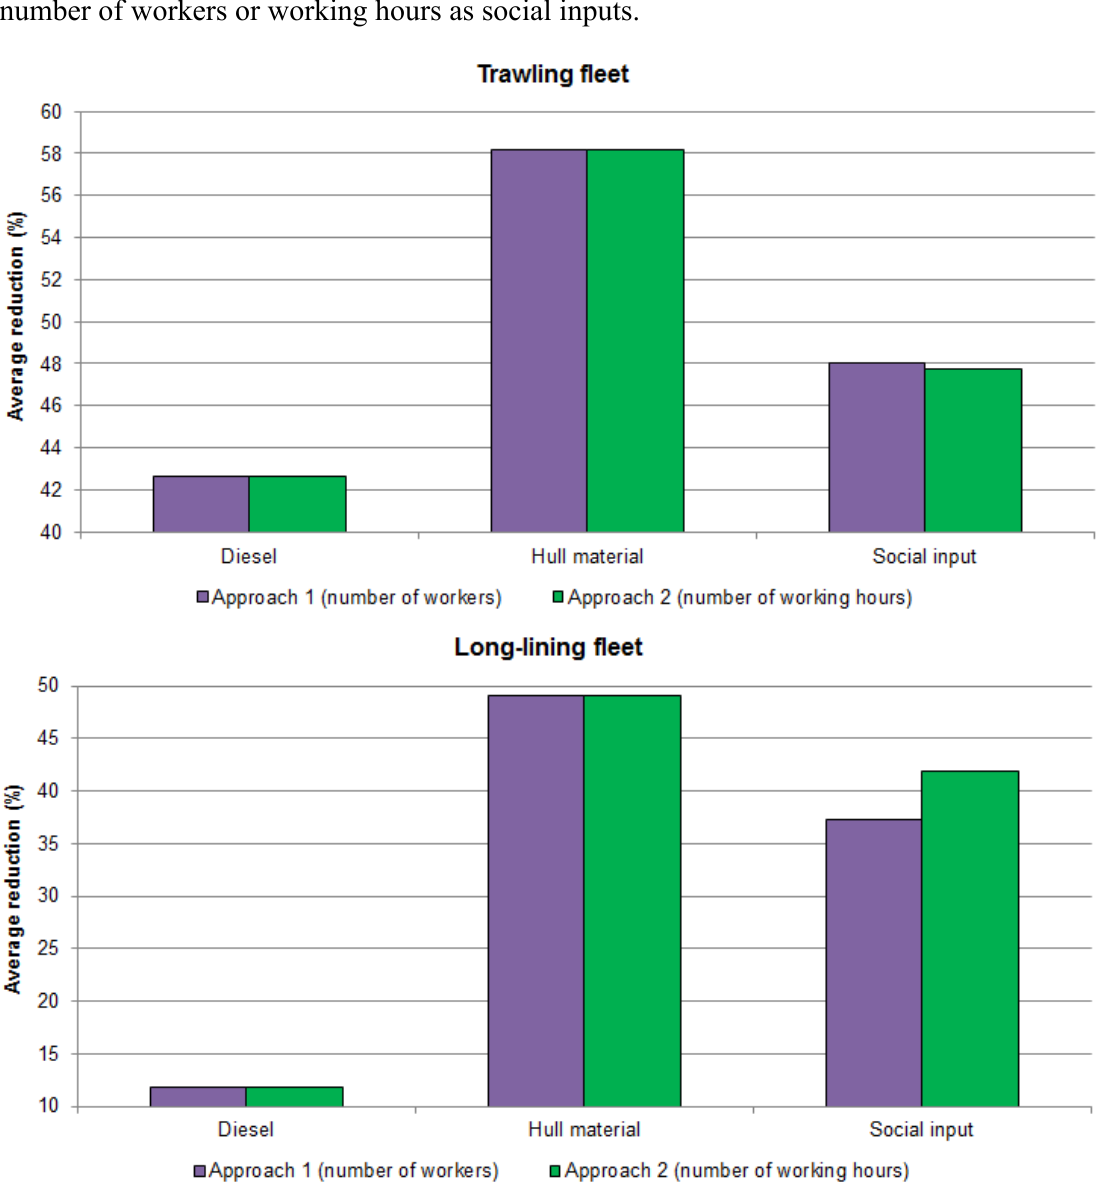
Figure 2. Average reduction in the selected inputs for the illustrative case studies using the number of workers or working hours as social